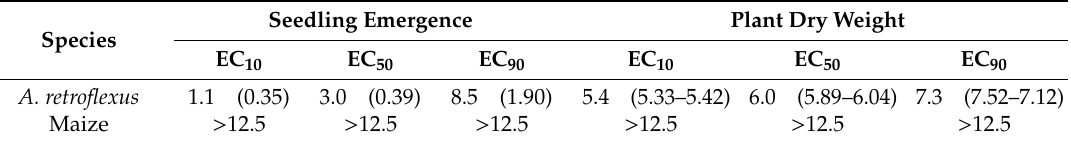
Figure 3. Emergence (graphic a ) and dry weight (graphic b ) of maize and A. retroflexus plants as affected by aerial biomass extract of mugwort. Symbols show observed data in the experiment 2, lines show fitted curves according to the models 1 and 2. Table 3. EC 10 , EC 50 and EC 90 values (% w / v ) of aerial biomass aqueous extracts of mugwort on seedling emergence and plant dry weight of maize and redroot pigweed ( A. retroflexus ) (standard errors and confidential intervals are in parentheses).